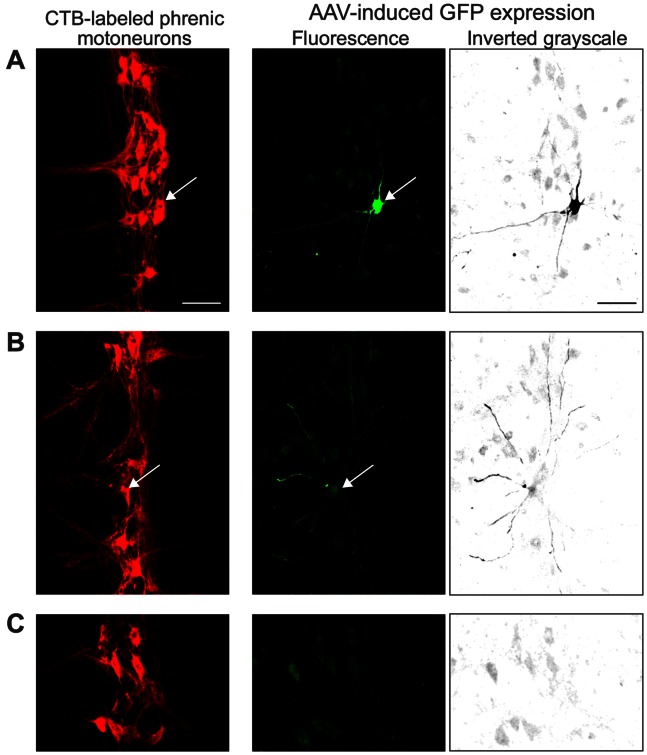
Retrograde delivery of adeno-associated virus (AAV) expressing GFP (AAV-GFP) to phrenic motoneurons by intrapleural injection.Representative confocal photomicrographs of retrogradely-labeled phrenic motoneurons were used to determine GFP co-localization at individual motoneurons. Images shown are maximum intensity projections of confocal slices showing a longitudinal section at ∼C3–4 (orientation: rostral, top; medial, left)., with side-by-side pictures showing the 2 fluorescence channels from the same projection – cholera toxin subunit B-labeled phrenic motoneurons (red) and GFP expression (green). GFP expression was also converted to grayscale and inverted to facilitate visualization (black). A) AAV7-GFP resulted in selective GFP expression in phrenic motoneurons in all treated animals at 3 weeks (n = 6) and 10 weeks (n = 1) after ipsilateral injection. B) AAV7-GFP also resulted in extensive labeling of phrenic motoneuron dendrites but the cell somata were not always identifiable in the same or neighboring spinal cord sections, likely due to GFP leaking after paraformaldehyde fixation, as seemingly happens with eGFP expression. C) Lack of GFP immunoreactivity in the phrenic motoneuron pool 3 weeks after intrapleural saline treatment (n = 6). Images were acquired such that background autofluorescence in the GFP channel was allowed in order to maximize visualization of motoneuron dendrites. Bar, 100 µm in A–C.